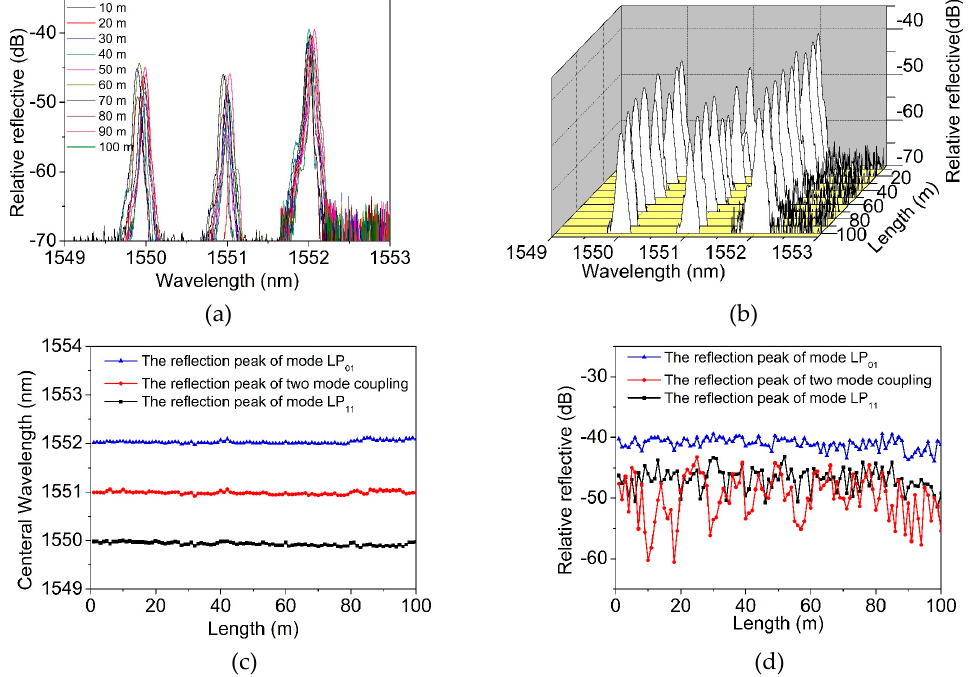
Figure 10. The measurements of two-mode FBG array for ( a ) and ( b ) spectra, ( c ) center wavelength, ( d ) reflection peak intensity.